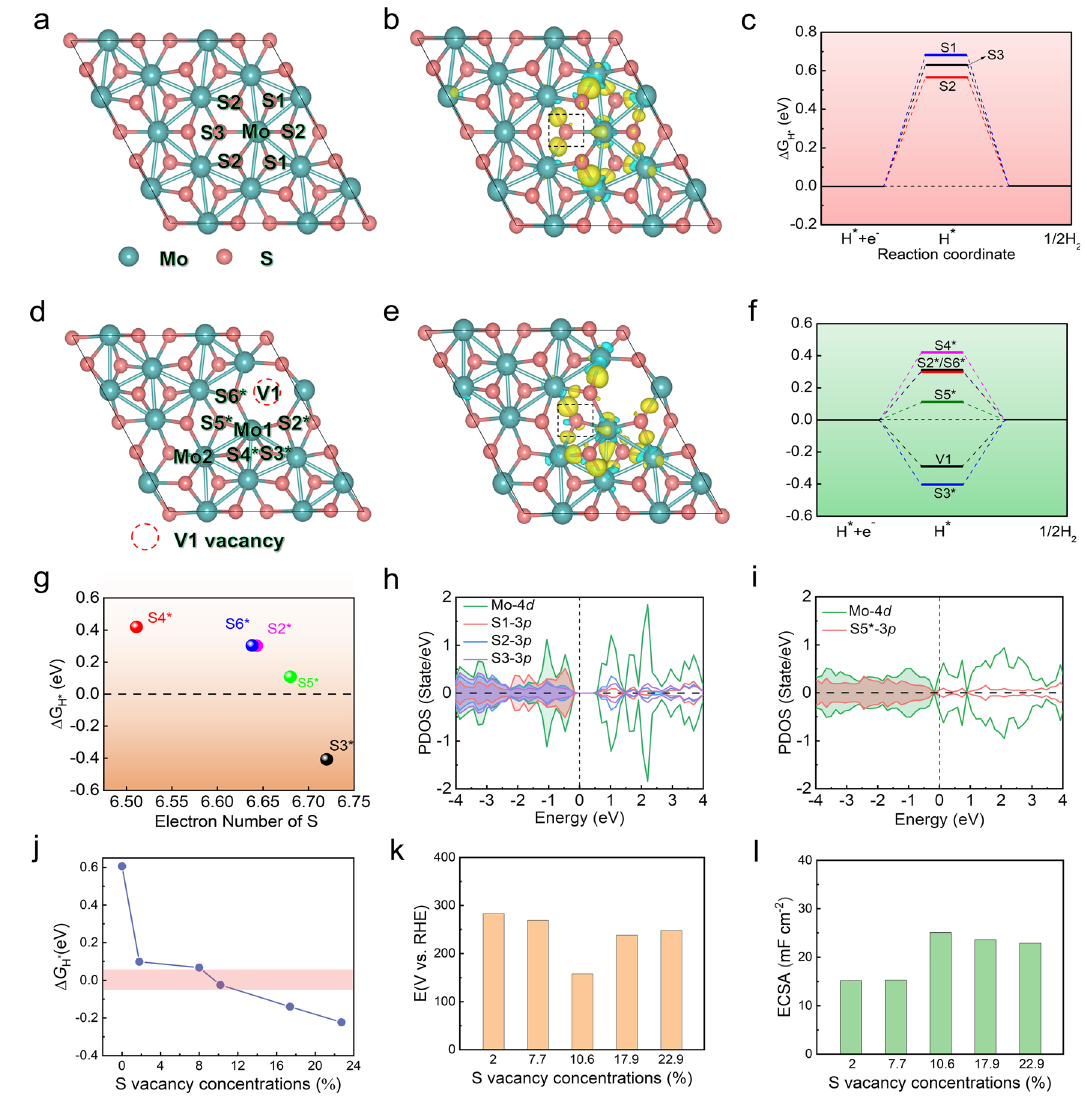
Fig.4|Calculatedhydrogenadsorptionfreeenergiesandelectronicstructures of multiple active sites in 1T'''-MoS 2 , 1T'''-MoS 2 -V1 (V1: S vacancy). a , d The optimized structure of 1T'''-MoS 2 , 1T'''-MoS 2 -V1. b , e The correspondingly calcu- latedchargedensitydifferenceofdifferentadsorptionSsitesin1T'''-MoS 2 and1T'''- MoS 2 -V1. The yellow and blue regions indicate the accumulation of positive and negative charge, respectively. c , f Δ G H* in different exposed S atoms around Mo